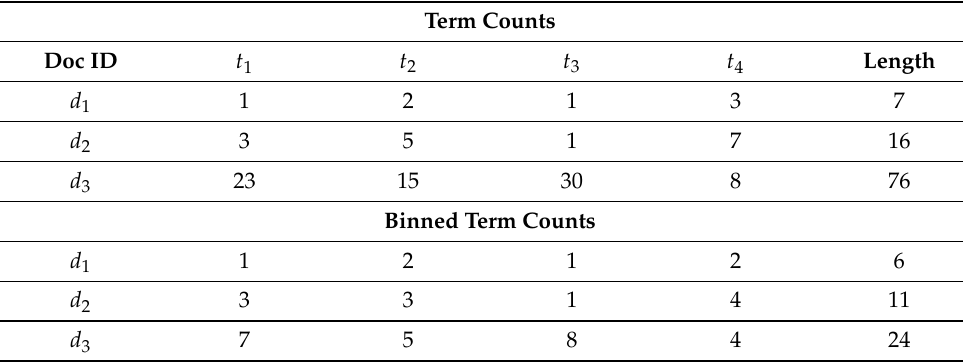
Table 4. Another motivating